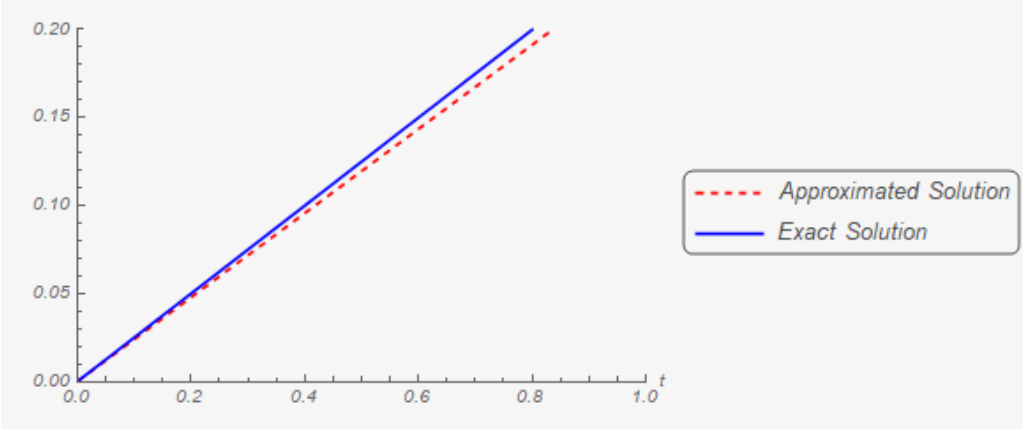
Figure 8. The second component of the exact solution and its one hundred and fifth approximation.